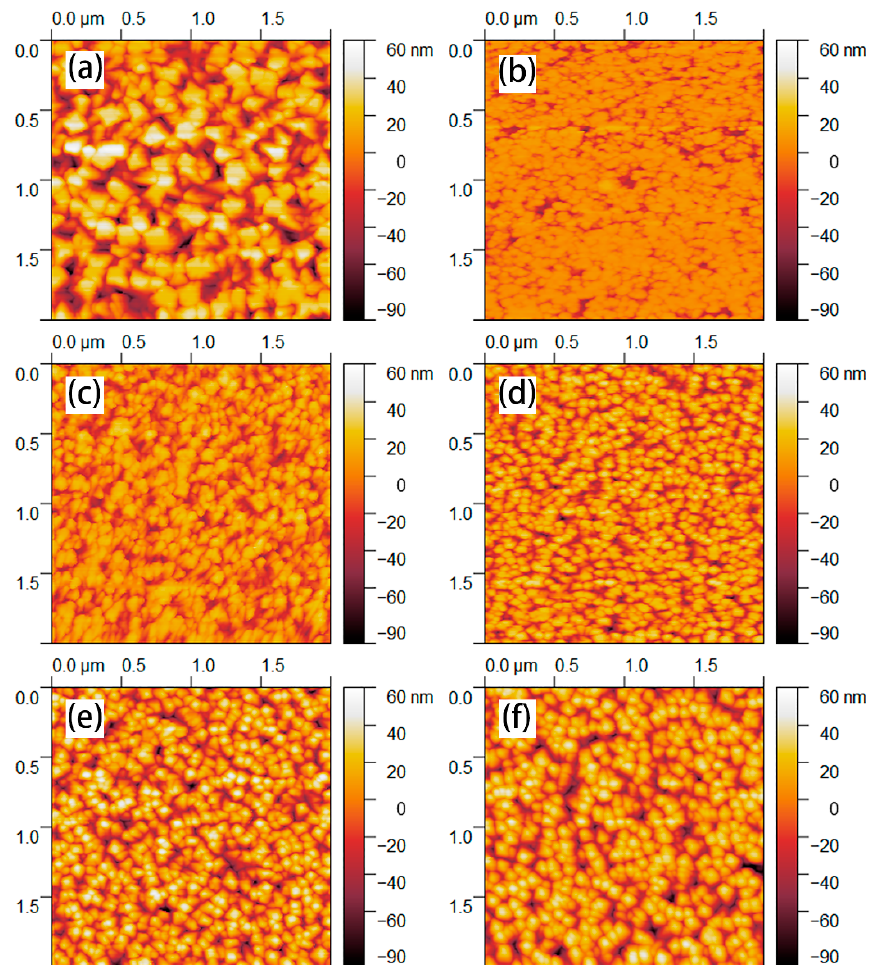
Figure 5. 2D morphology of films by atomic force microscope (AFM) ( a,b ) Monolayer granular and nanopillar crystalline films; ( c – f ) The multiple structure nanopillar crystalline films deposited at 100 W, 150 W, 200 W and, 250 W, respectively.